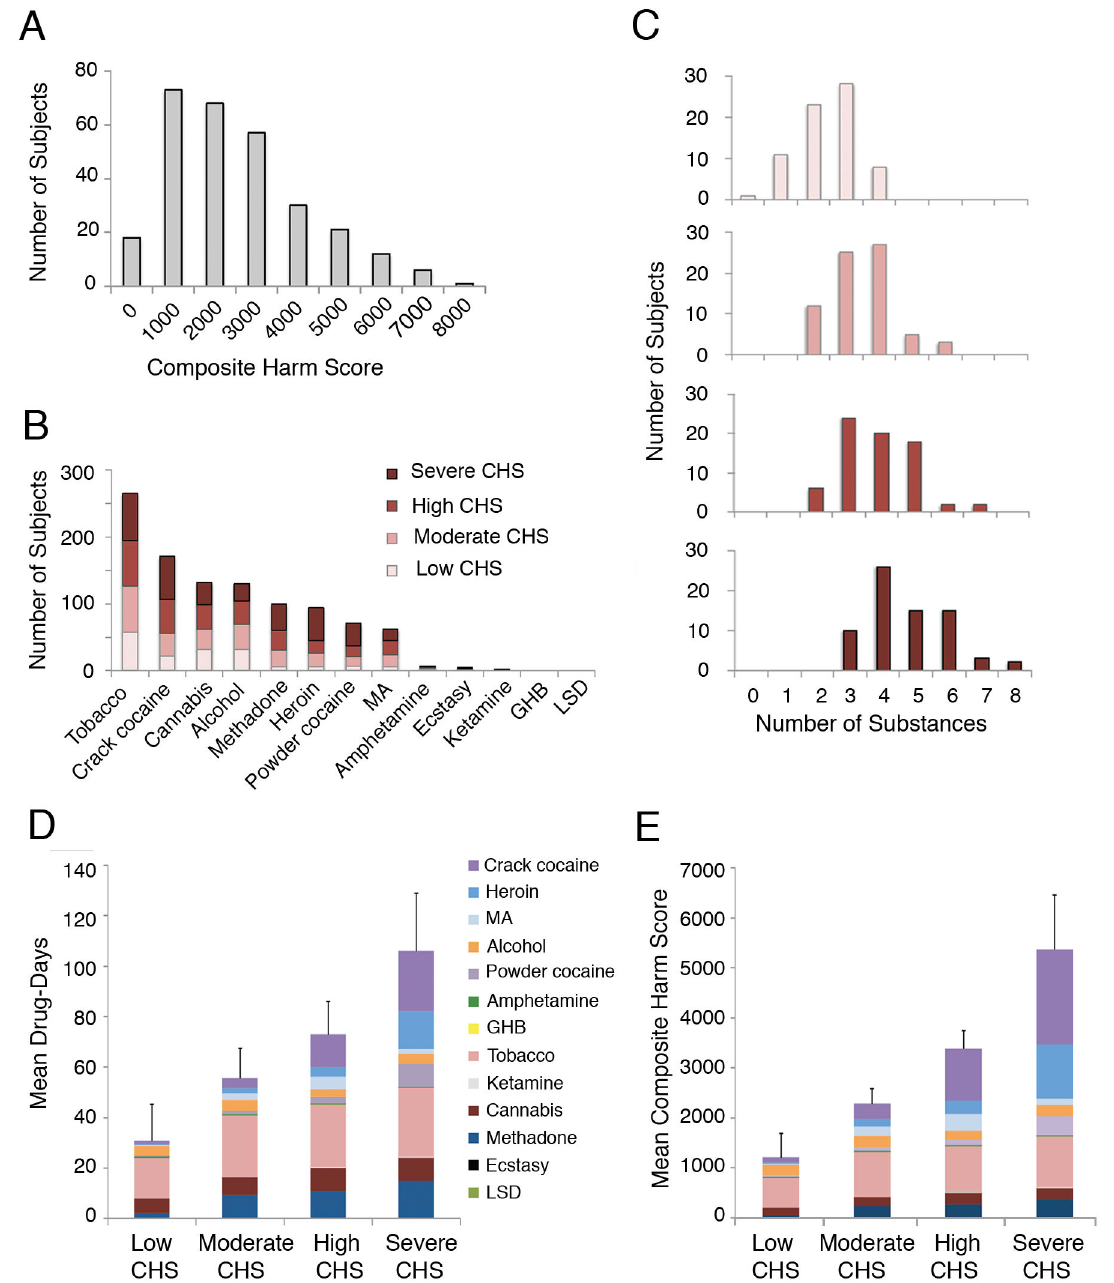
Figure 1. Composite harm scores. Panel A shows the distribution of Composite Harm Scores of the cohort from the first month of study. Panel B shows the prevalence of types of substance use during the first month of study across CHS quartile groups. MA: methamphetamine. Panel C shows the number of subjects in CHS quartile groups using multiple substances during the first month of study. Panel D shows the mean sum of the number of days using each substance during the first four weeks of the study for CHS quartile groups. Colors represent individual drugs, ordered from top to bottom in decreasing ISCD harm to user scores. Error bars indicate SD. Panel E shows the mean CHS for each CHS quartile group, colors indicating the contribution of harm from each substance (ISCD drug harm score * frequency) to the mean CHS value for the quartile group. Error bars indicate SD.